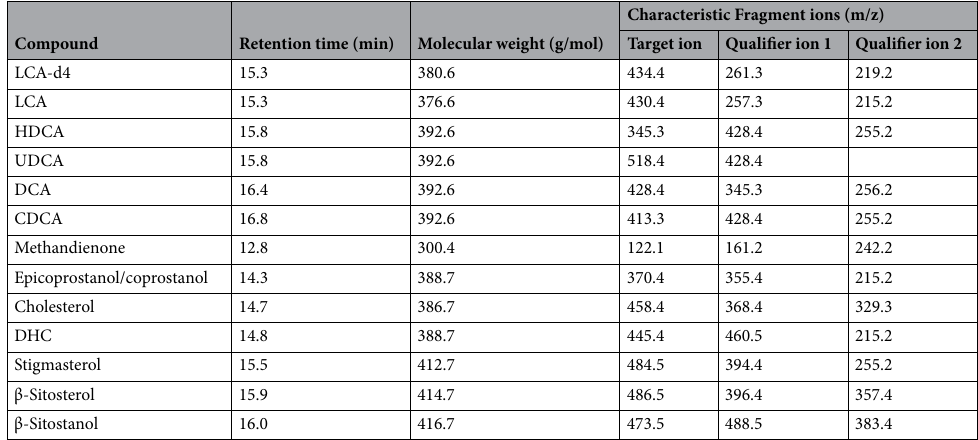
Table 2. Retention time, molecular weight and mass spectral characteristics of BAs, sterols and stanols (analyzed as TMS derivatives).